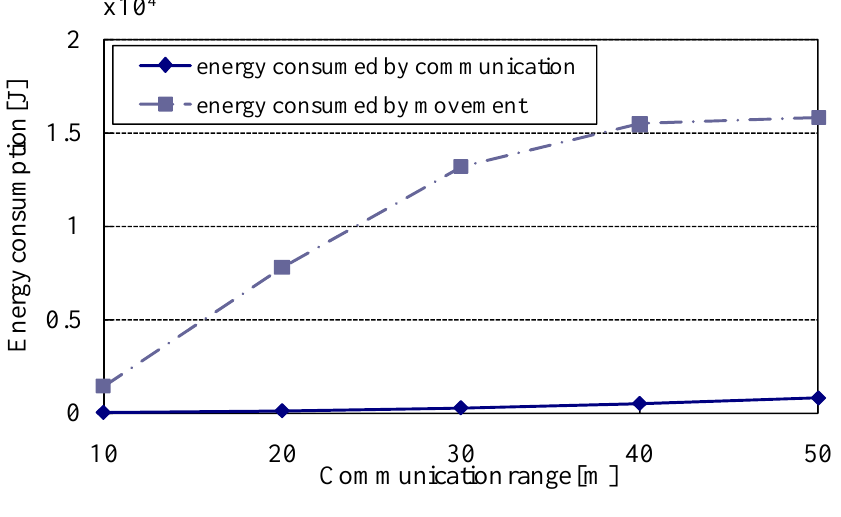
Figure 21. Communication range and the energy consumption in